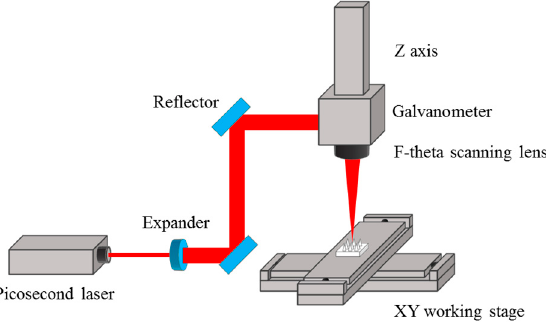
Figure 3. Schematic overview of the picosecond laser processing platform. The picosecond laser had three wavelengths of 1064, 532, and 355 nm, which can be switched, the pulse width was 10 ps, and the repetition frequency was 1–50 MHz. The 355-nm ultraviolet laser was applied to ensure laser processing work in the photochemical regime. The F-theta scanning lens used in this system had an effective focal length of 70 mm and the final focused laser spot diameter was about 5 µ m.